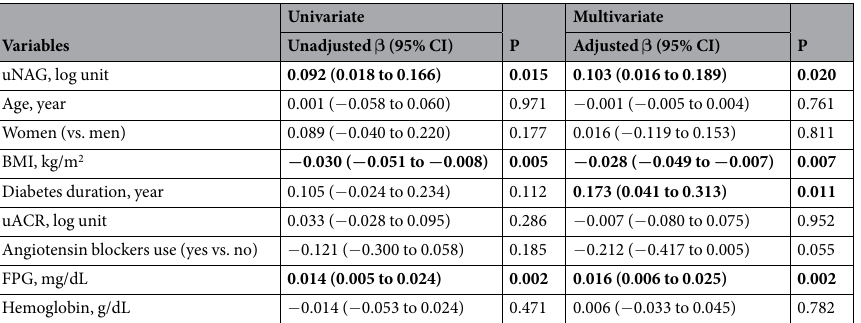
Table 4. Association of uNAG excretion with G/A ratio in subjects with type 1 diabetes. uNAG and uACR were log-transformed for linear regression models (log-uNAG and log-uACR). In multivariate model, β coefficient of uNAG for G/A ratio was reported with adjustment for age, sex, BMI, duration of diabetes, log- uACR, angiotensin blockers use, FPG, and hemoglobin. Bold characters represent statistically significant values. Abbreviations: uNAG, urinary N-acetyl- β -D-glucosaminidase; BMI, body mass index; uACR, urinary albumin- to-creatinine